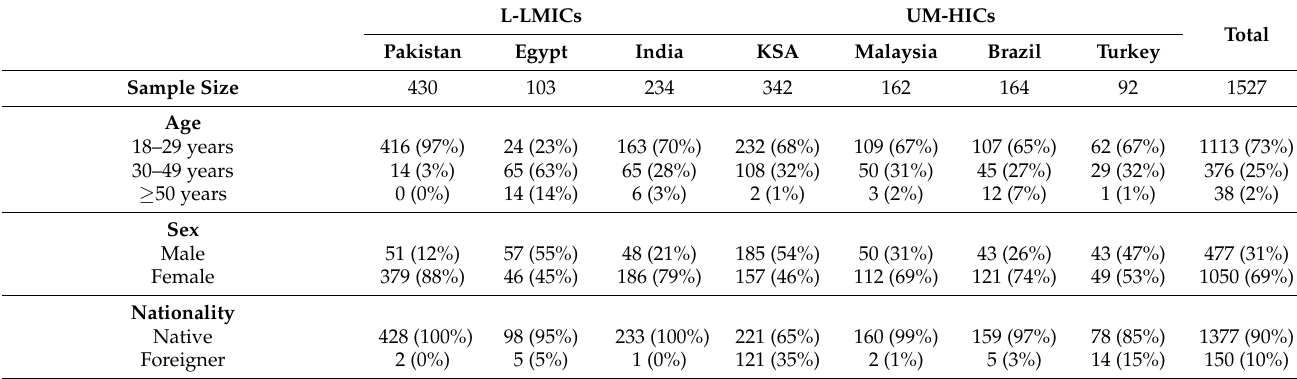
Table 1. Sample characteristics: Data are presented as n